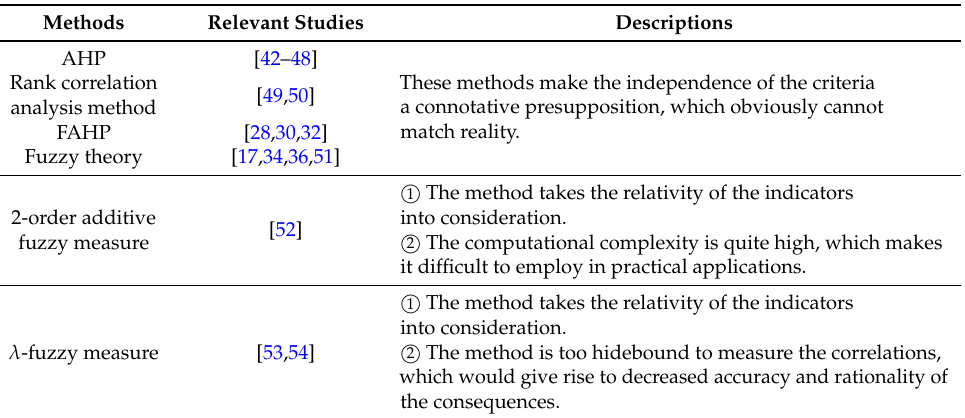
Table 2. Methods to determine the weights of the